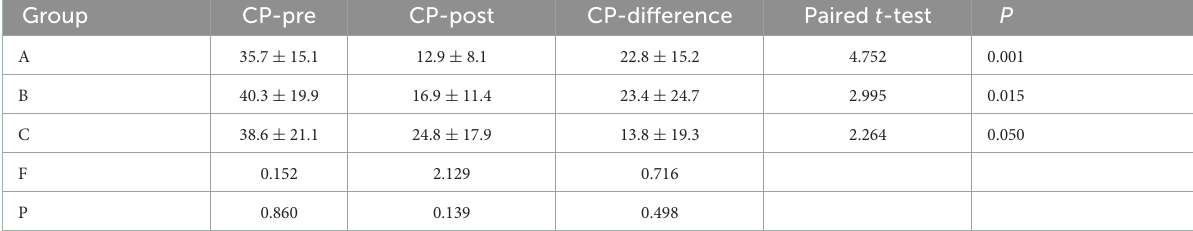
TABLE 4 Comparison of CP between and within groups before and after